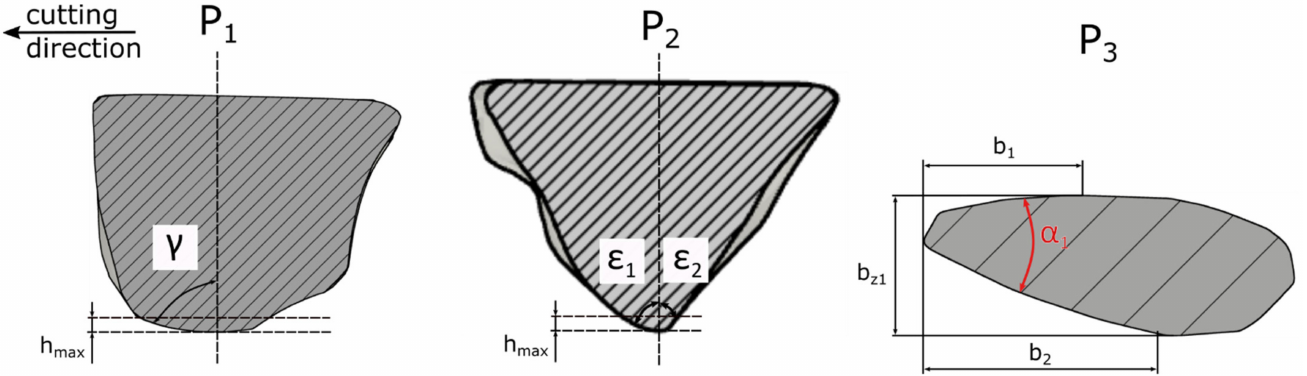
Figure 5. Geometrical properties of abrasive grain ZS1.